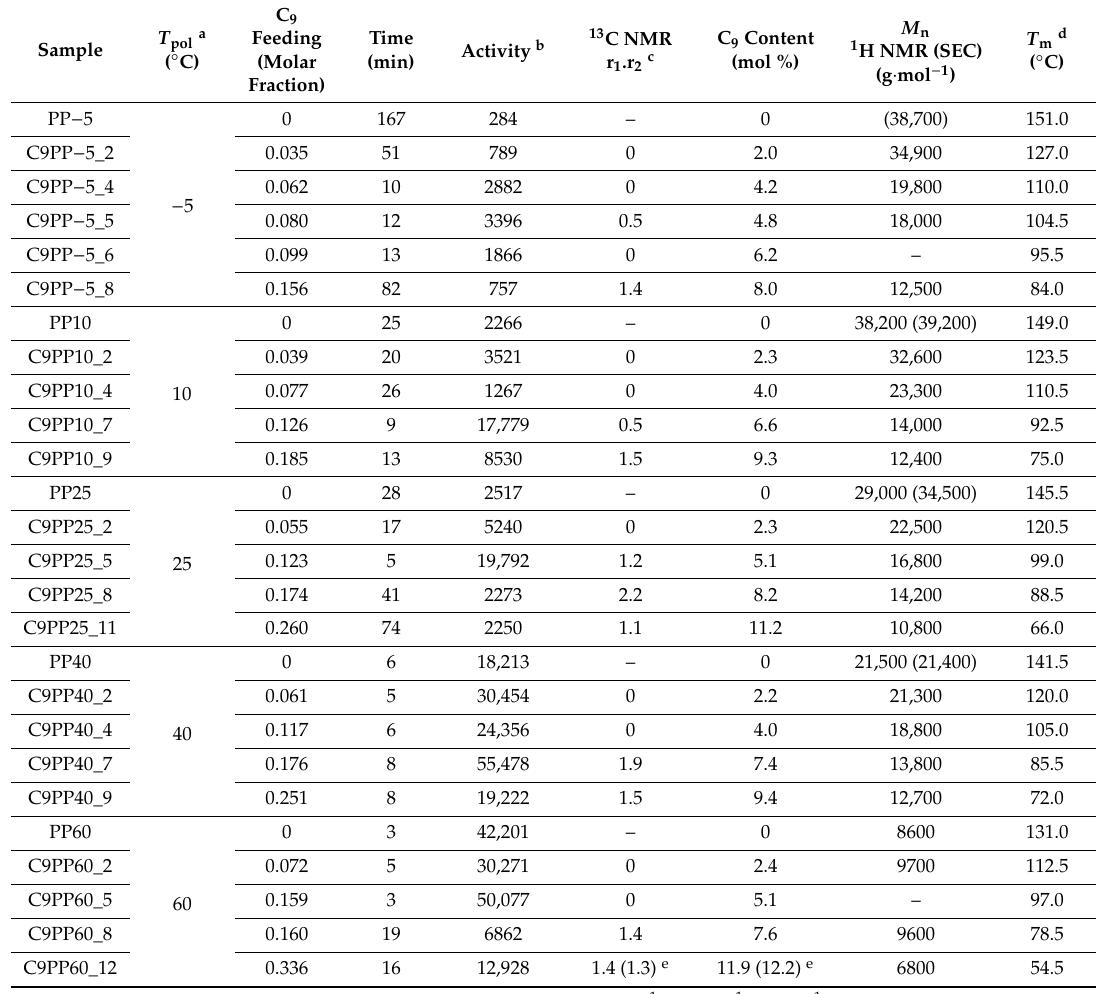
Table 1. Characteristics of polymerization runs and